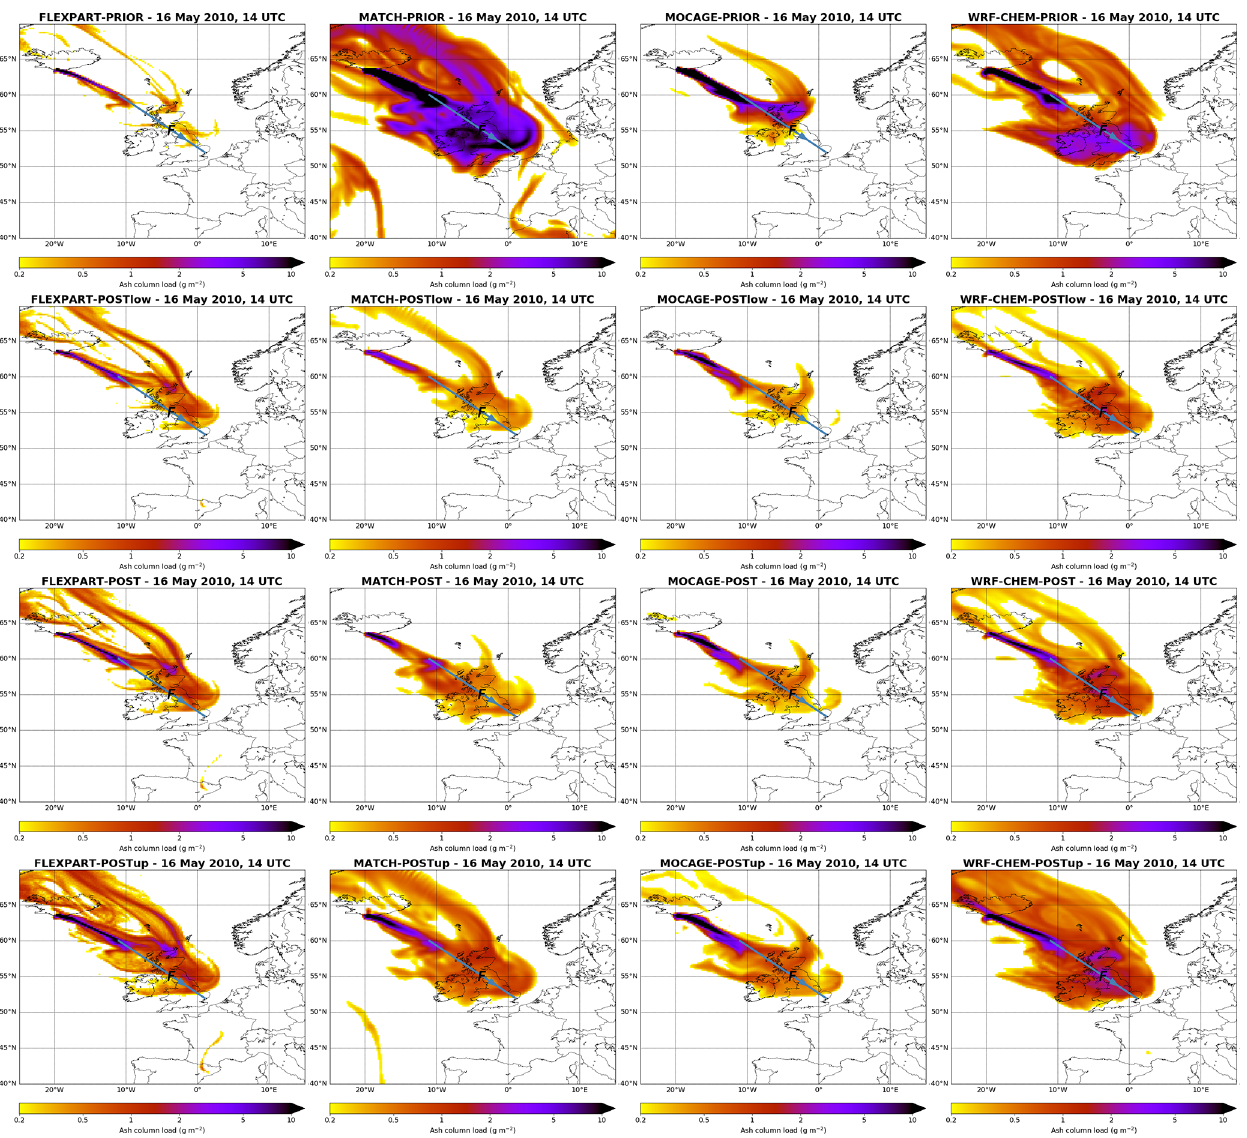
Figure 5. Ash column load on 16 May at 14:00UTC for the four models (from left to right: FLEXPART, MATCH, MOCAGE, and WRF- Chem). The top panel shows the four model outputs with a priori source terms. The three other rows show respectively (from top to bottom) the four model outputs with the lower limit of the a posteriori source term, the best-estimate a posteriori source term, and the upper limit of the a posteriori source term. The model outputs can be compared to the observed values in Fig. 3. The blue lines are the same as in Fig.